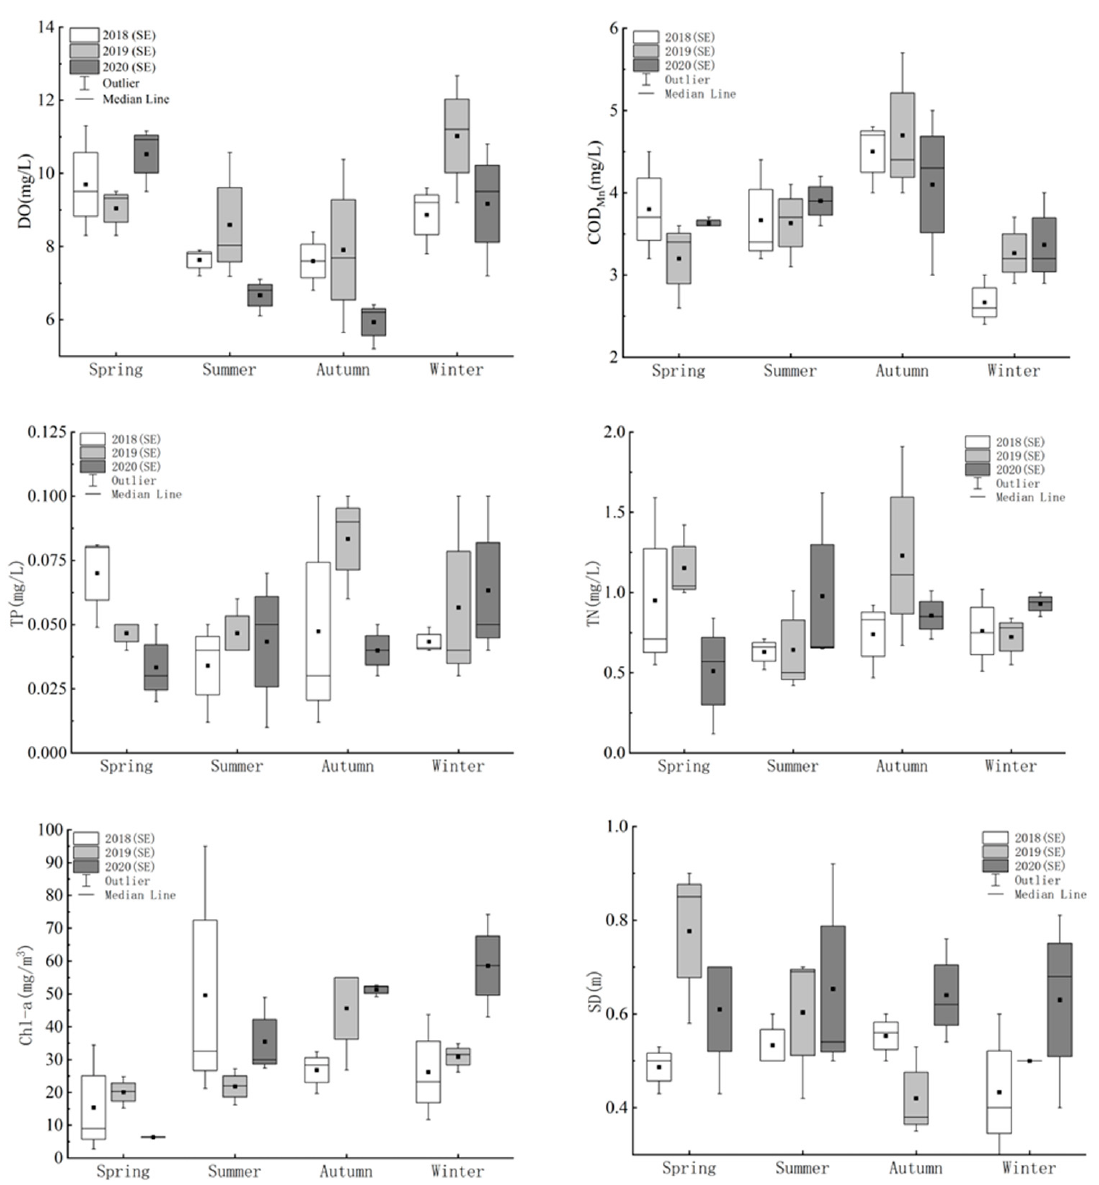
Figure 2. Seasonal variation in water quality indicators.